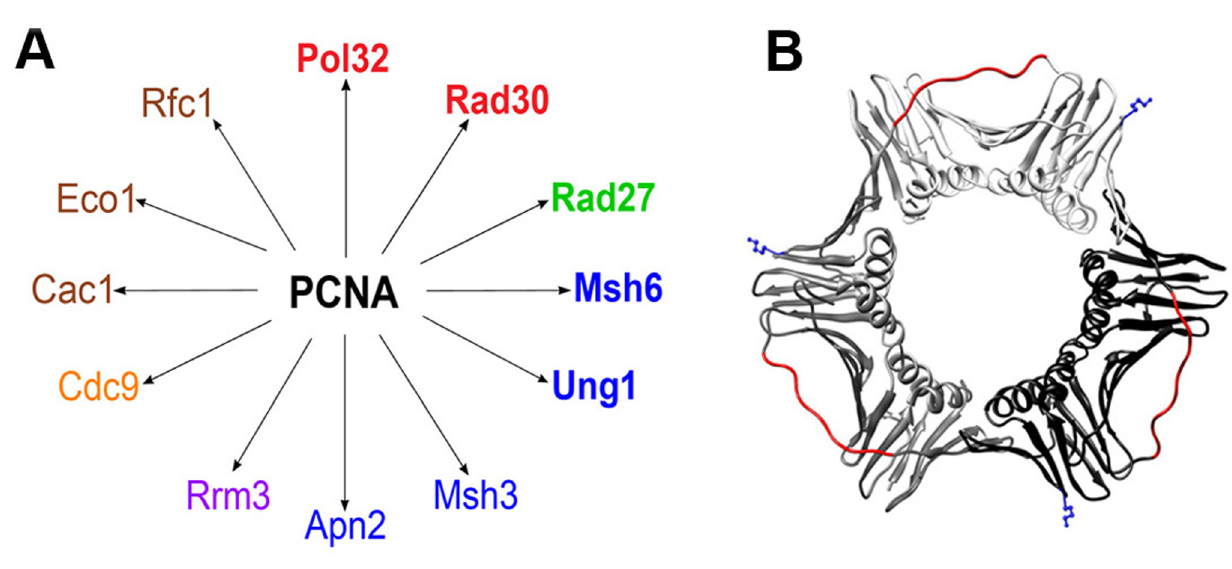
Figure 1. PCNA-partner interaction network mediating DNA replication and repair and PCNA structure. (A) PCNA-partner interaction network containing the 12 PCNA partners containing PCNA-interacting protein (PIP) used in this study, including DNA polymerases (Pol32 and Rad30, red), an endonuclease (Rad27, green), partners involved in DNA repair (Msh3, Msh6, Apn2 and Ung1, blue), a helicase (Rrm3, purple), a ligase (Cdc9, orange), and partners involved in various processes, including loading PCNA onto DNA (Rfc1, brown), sister chromatid cohesion (Eco1, brown), and chromatin acetylation (Cac1, brown). PCNA was evolved for higher binding affinity for Pol32, Rad30, Rad27, Msh6, and Ung1 (highlighted in bold). (B) Model of the PCNA structure (PDB code:1PLQ) [25]. Each monomer is shown in white, grey, or black. The IDCL loop is highlighted in red and the K164 residue is highlighted in blue. The model was generated using the UCSF chimera program.